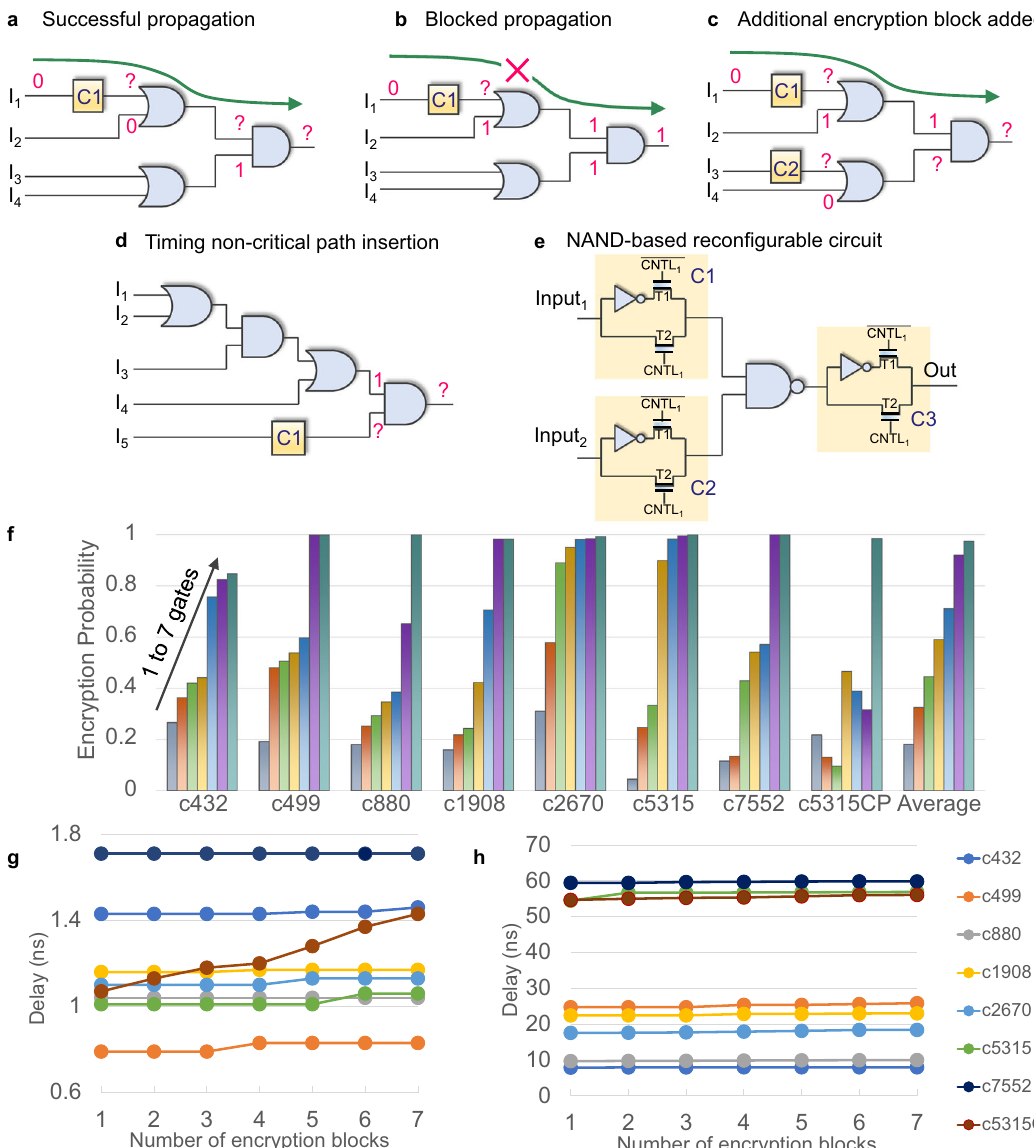
Fig. 3 Analysis of placement ultra-compact FeFET encryption logic on encryption probability, timing and logic recon fi gurability. a Successful propagation of an encrypted bit from C1. b Encrypted bit from C1 blocked by OR gate. c Enhancing encryption probability by inserting additional encryptor. d Placement of interconnect based encryption unit in a non-critical timing path. e Recon fi gurable logic based on NAND and active interconnect